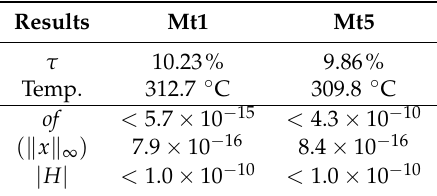
Table 10. Optimization results for CO and two material types Mt i ; i = 1,